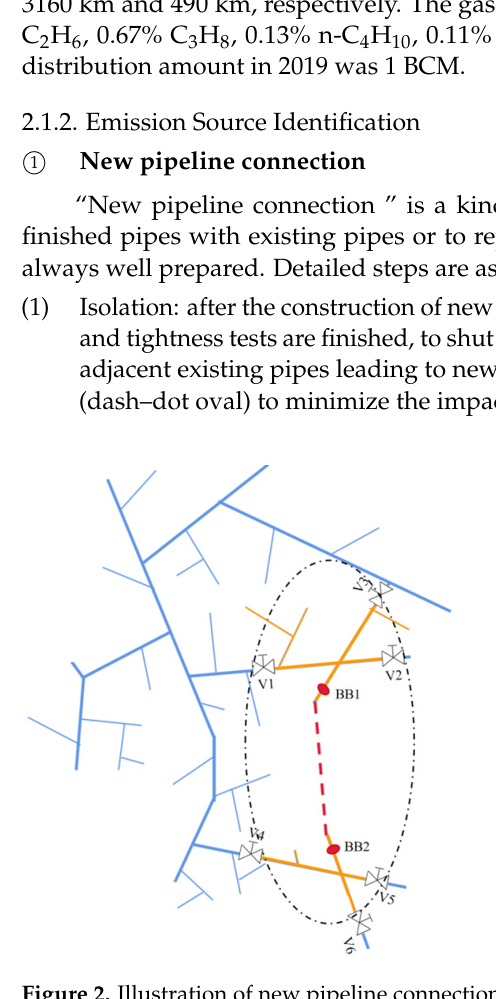
Figure 2. Illustration of new pipeline connection.